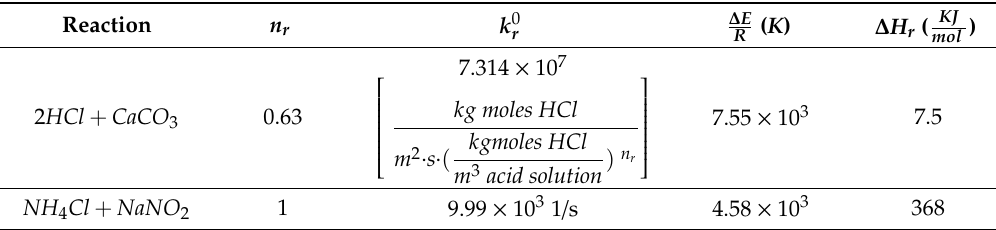
Table 2. Reaction kinetics constants and heat of reaction for acid and TC